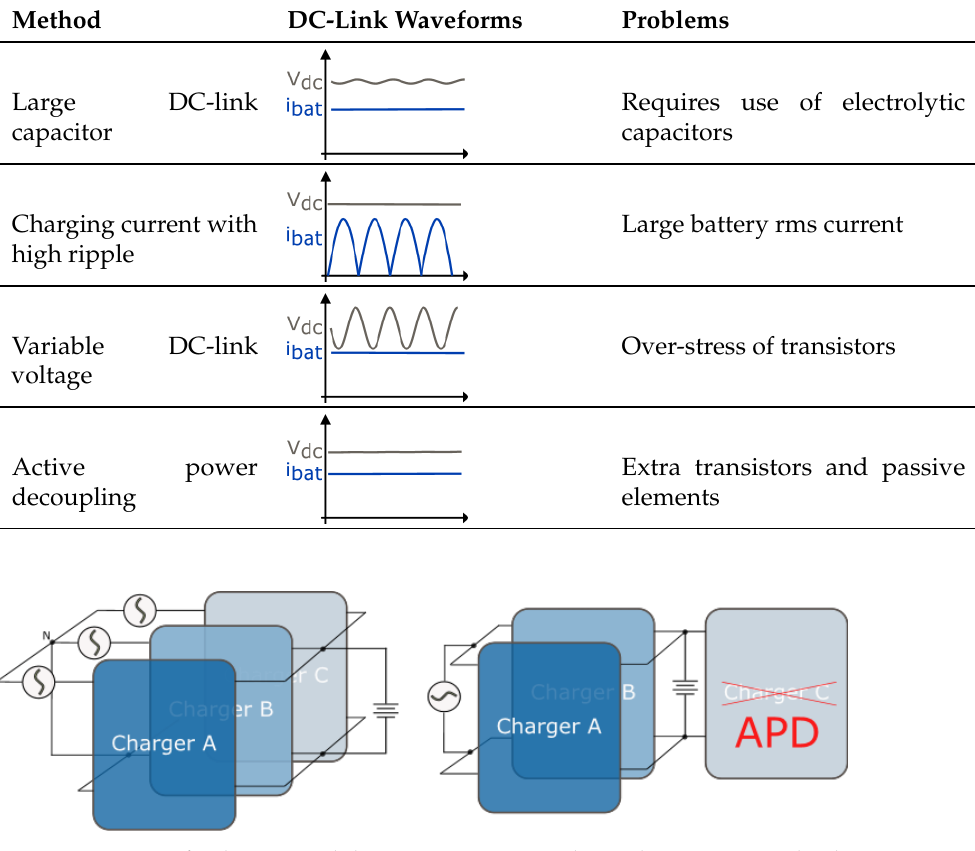
Figure 14. Usage of a charger module as an active power decoupling unit in single-phase operation as explained in